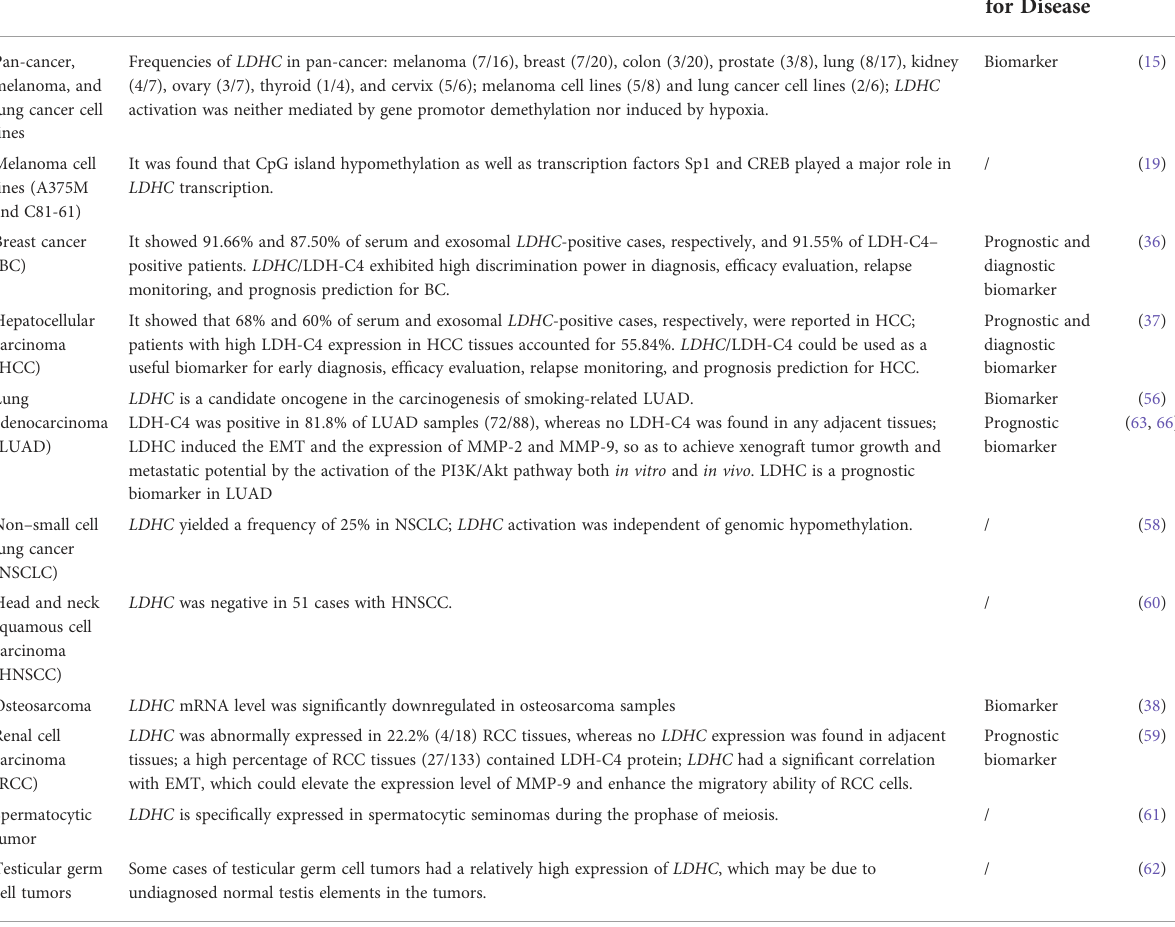
Reference for Disease